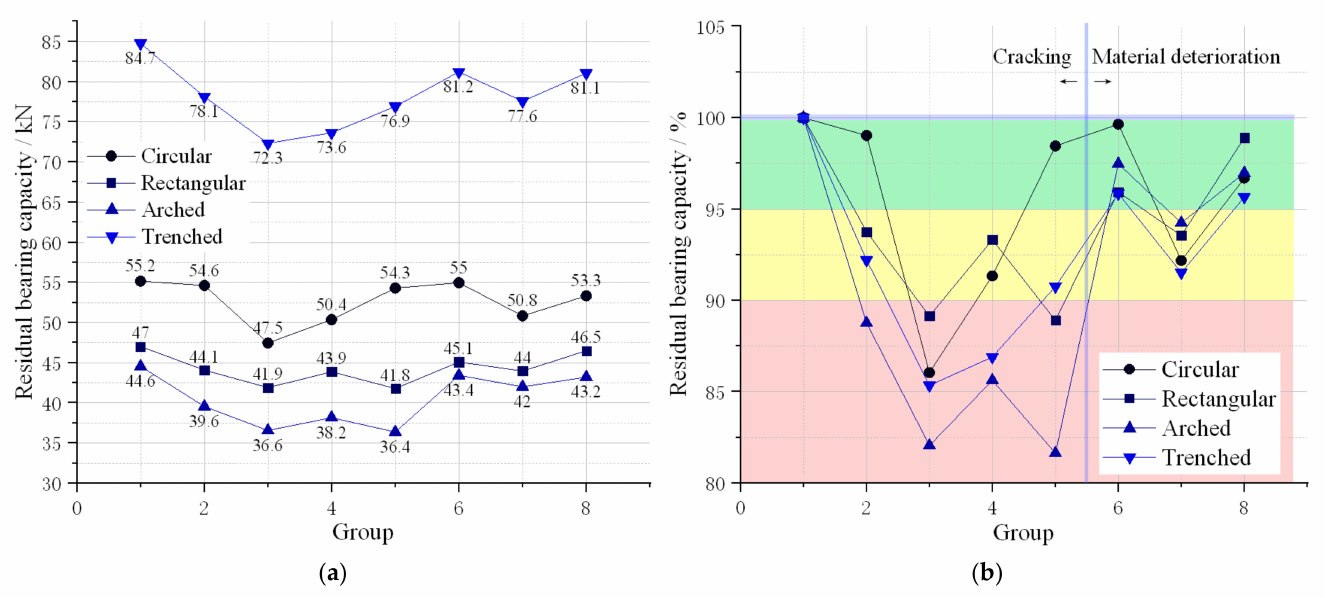
Figure 13. ( a ) Failure loads of all groups; ( b ) The defective model failure load to intact model failure load